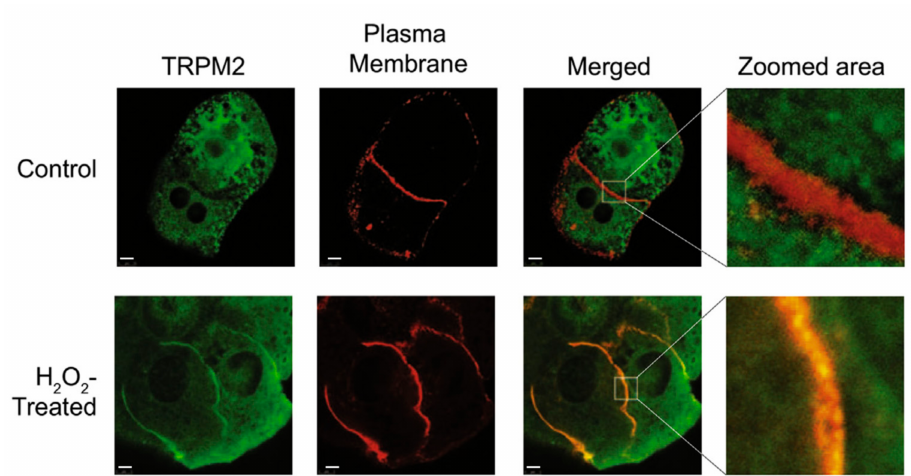
Figure 5. In rat hepatocytes, H 2 O 2 induces the movement of some TRPM2 protein from intracellular locations to the plasma membrane. Confocal microscopy images (100 × magnification) of untreated control hepatocytes (Control) and hepatocytes treated with H 2 O 2 (H 2 O 2 treated). Green fluorescence corresponds to TRPM2 and red fluorescence to cadherin (marker protein for the plasma membrane). Yellow indicates the overlap between green and red fluorescence (Merged and Zoomed area), rep- resenting TRPM2 and the plasma membrane, respectively. Reproduced with permission from [43], copyright 2018